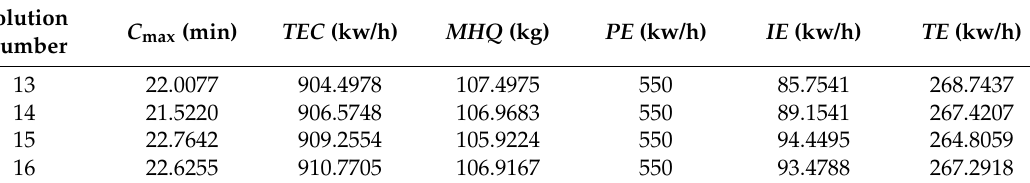
Table 6. The solutions in the trough and the peak.